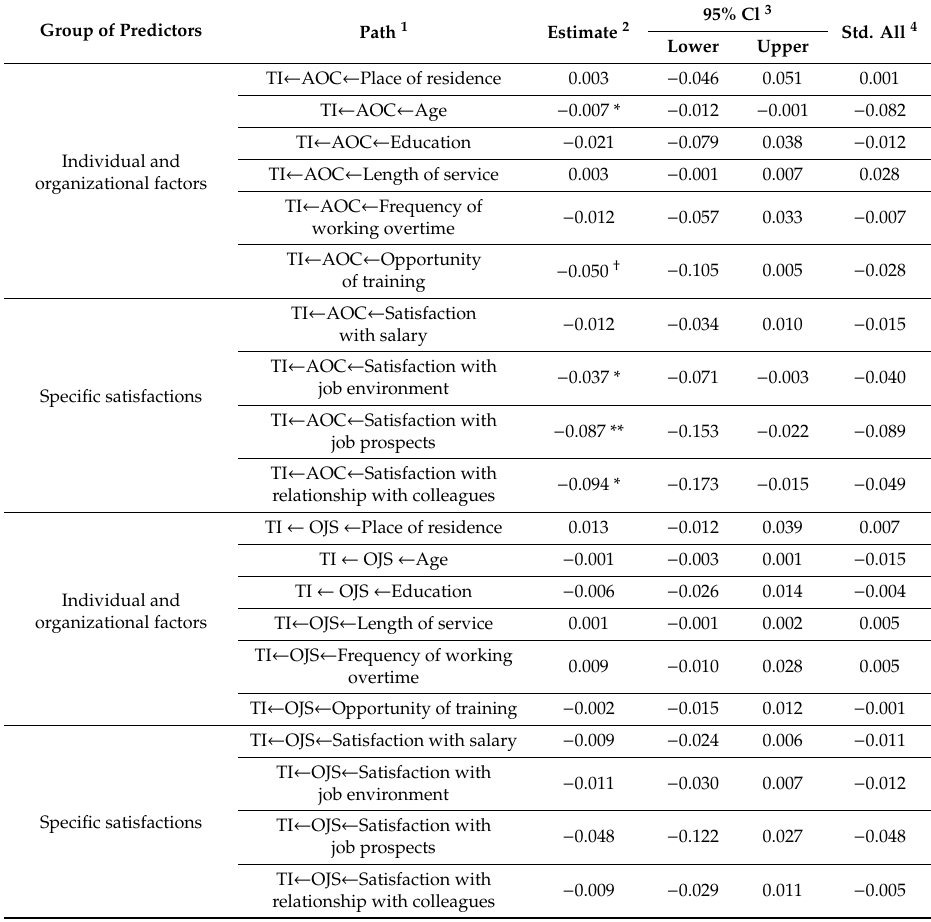
Table 3. The indirect e ff ects shown by the SEM